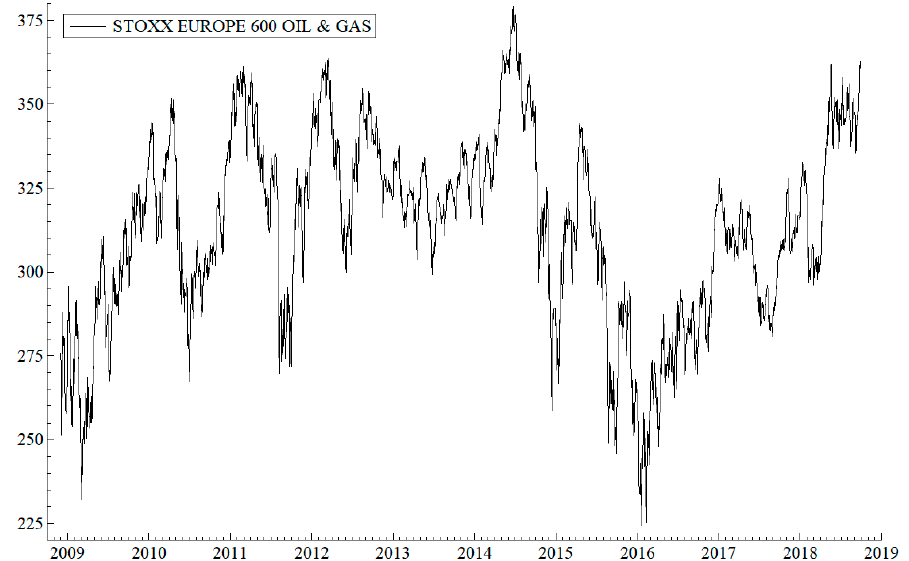
Figure 11. Daily prices in Stoxx600 Europe Oil and Gas Index before dividends in Euro/index share, 2 December 2008 to 28 September 2018.